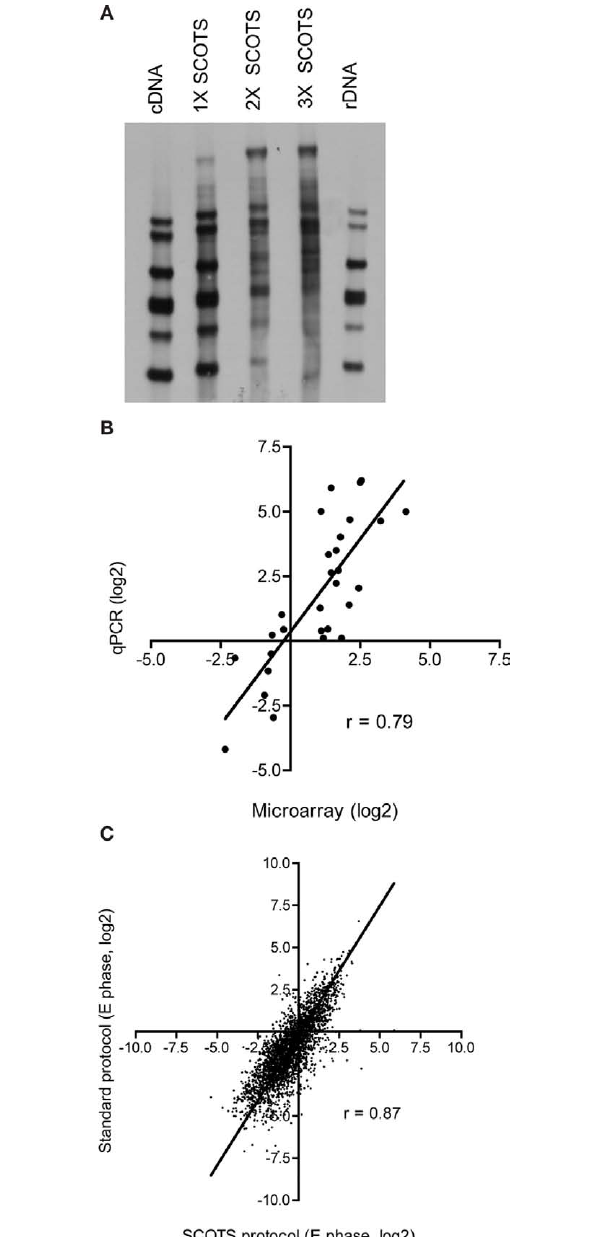
FIgURe 2 | effects of SCOTS on the cDNa population. (a) Southern blot of L. pneumophila gDNA digested with Hin cII and hybridized with labeled cDNA from the T0 time point obtained before (lane 1) and after the first (lane 2), the second (lane 3), and the third (lane 4) round of SCOTS. Lane 5 was hybridized with labeled rDNA. (B) qPCR was used to validate the expression profiles obtained by microarray for eight genes in all the conditions. (C) Comparison of microarray data obtained when using the SCOTS amplification method and when using a standard microarray protocol. Shown is the normalized signal intensity obtained from E phase growth in rich AYE broth. See text